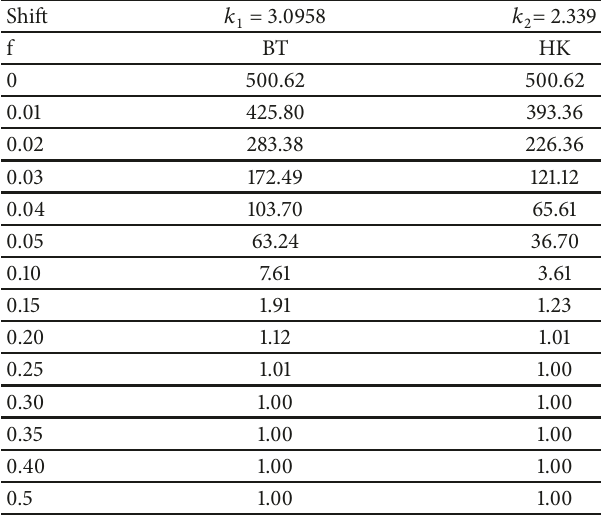
Table 13: ARLs for proposed repetitive EWMA-RSS control charts using exponential ratio-type estimators, for 𝜌 = 0.25 when 𝑟 𝑜 is 500 at 𝜆 =